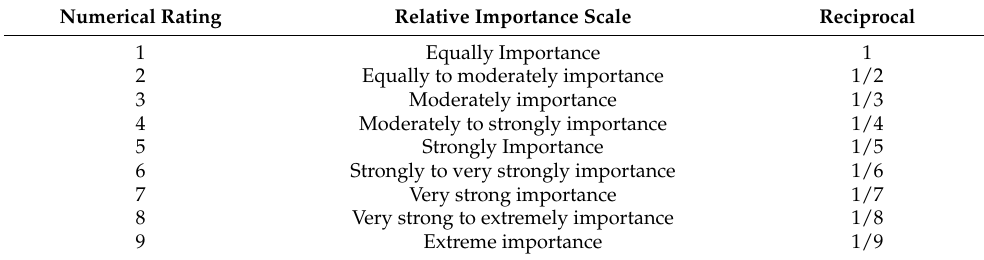
Table 5. The relative importance of the two